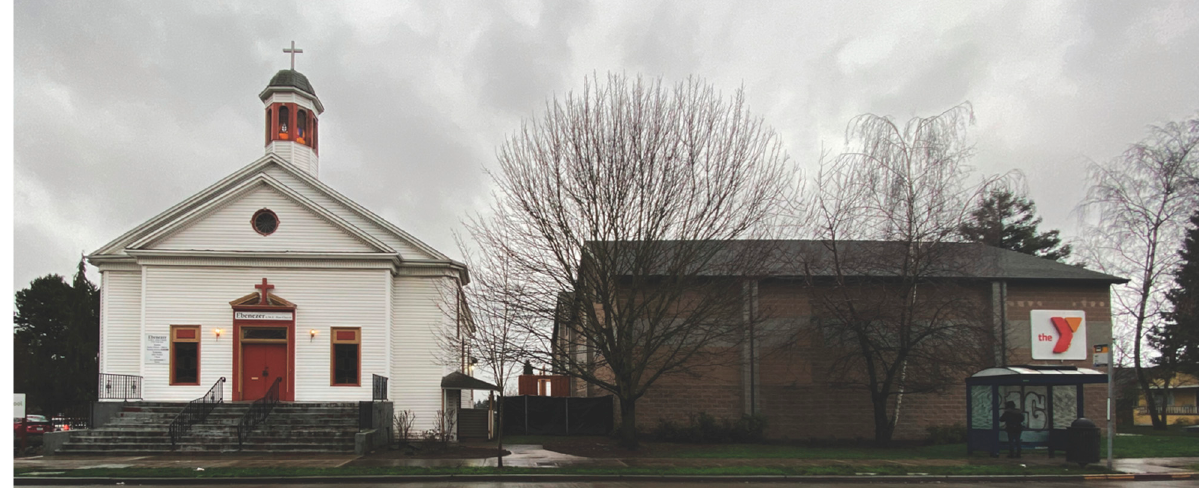
Figure 4. Existing Ebenezer AME Zion Church and the Meredith Mathews East Madison Y seen from 23rd Ave S. Source: Aubree Nichols (Building Beloved Community, p. 60).